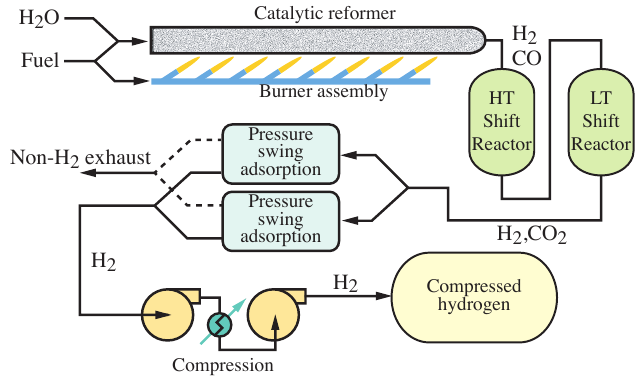
Figure 1. Process flow diagram for a typical industrial process to convert hydrocarbon fuels to compressed hydrogen. The two serial shift reactors operate at high (HT) and low (LT)